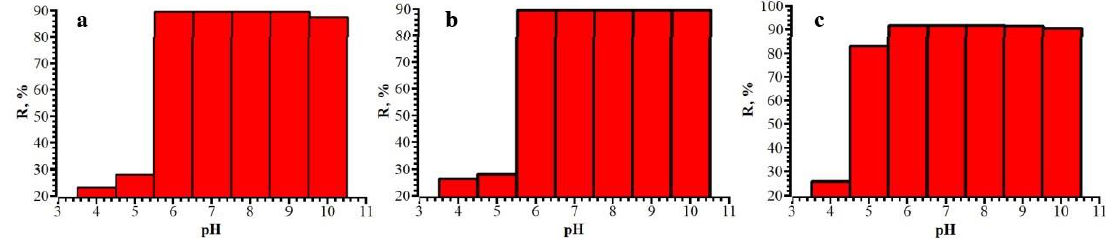
Figure 10. Dependence of the degree of extraction on the pH of the medium for CZO ( a ), CTX ( b ), CRO ( c ).